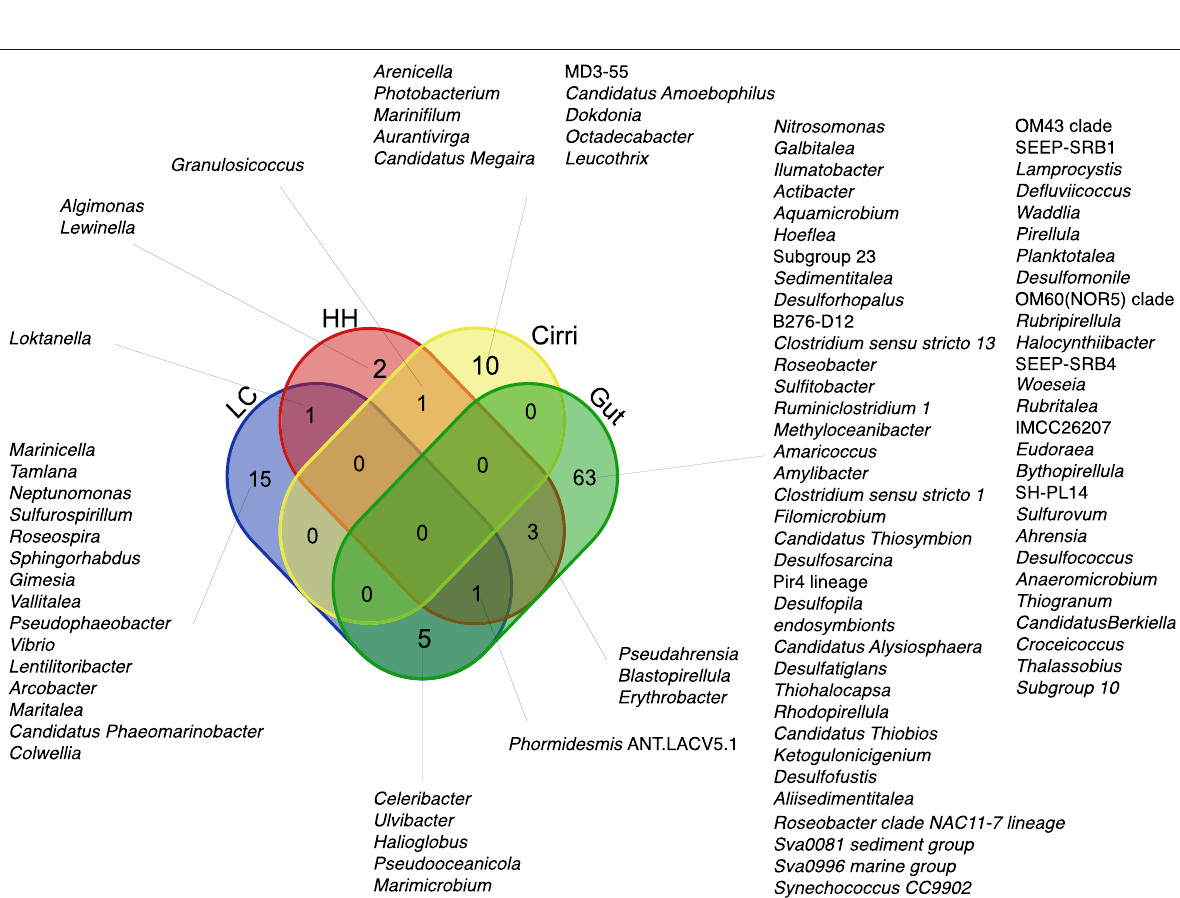
Fig. 4 Distribution of genera from ASVs enriched in body tissue (gut and cirri), and microhabitat (LC and HH) based on species indicator